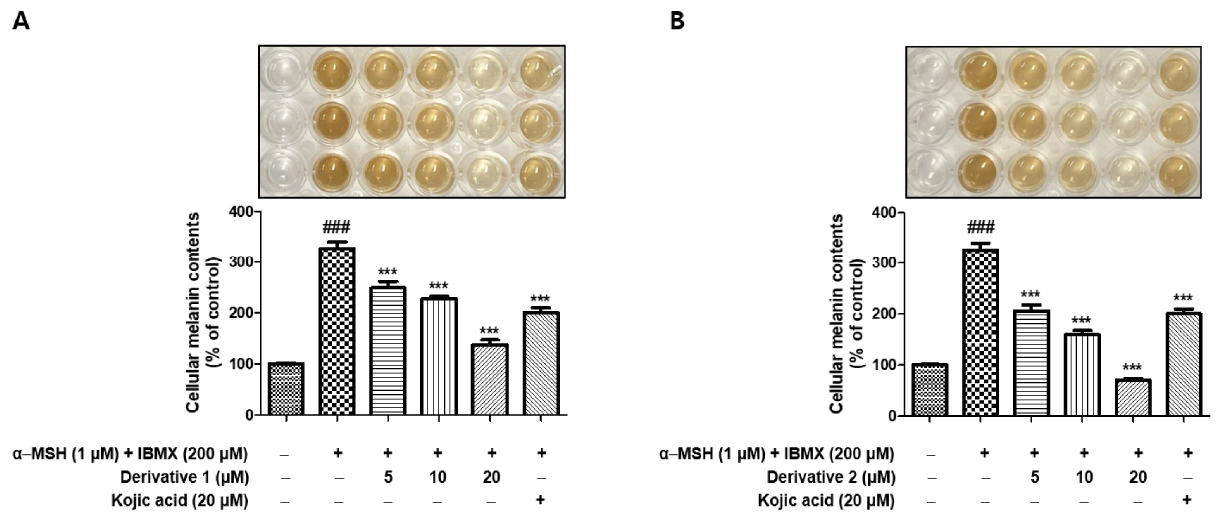
Figure 7. Effects of ( Z )-BPT derivatives 1 and 2 on cellular melanin levels in B16F10 cells. Kojic acid was used as a positive control. B16F10 cells were stimulated with 200 µ M of IBMX and 1 µ M of α -MSH in the presence of kojic acid (20 µ M) or ( Z )-BPT derivatives 1 and 2 (concentrations: 0, 5, 10, and 20 µ M) and incubated for 72 h. ( A ) Derivative 1 and ( B ) derivative 2 . Data are presented as the mean ± standard error of the mean. ### p < 0.001 for non-treated cells vs. stimulator-treated cells; *** p < 0.001 for stimulator-treated cells vs. cells treated with 1 or 2 plus stimulators.